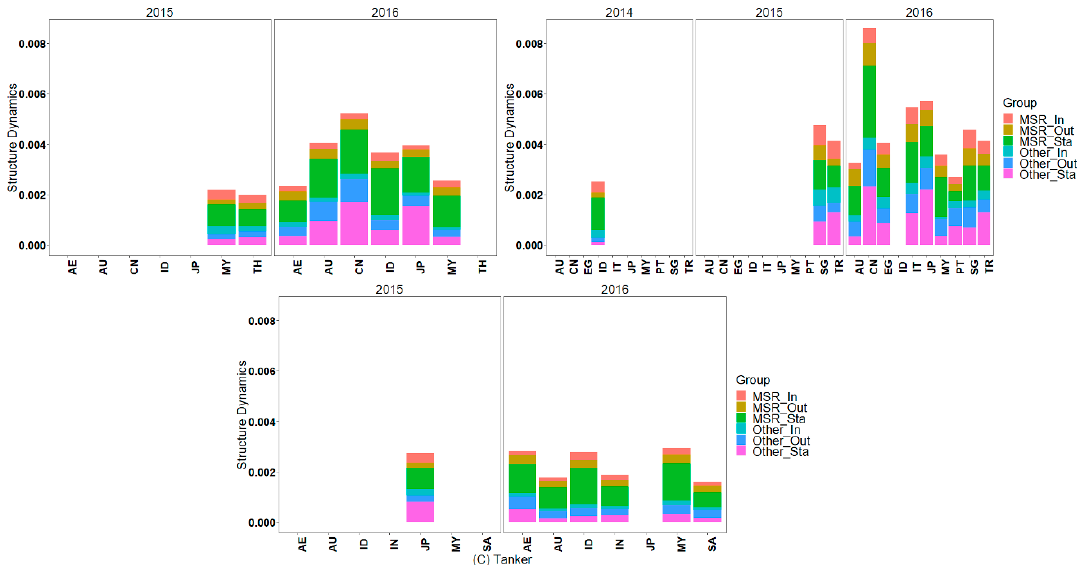
Figure 11. Maritime network structure with evident dynamics; (a) Bulk network, (b) container network, and (c) tanker network.